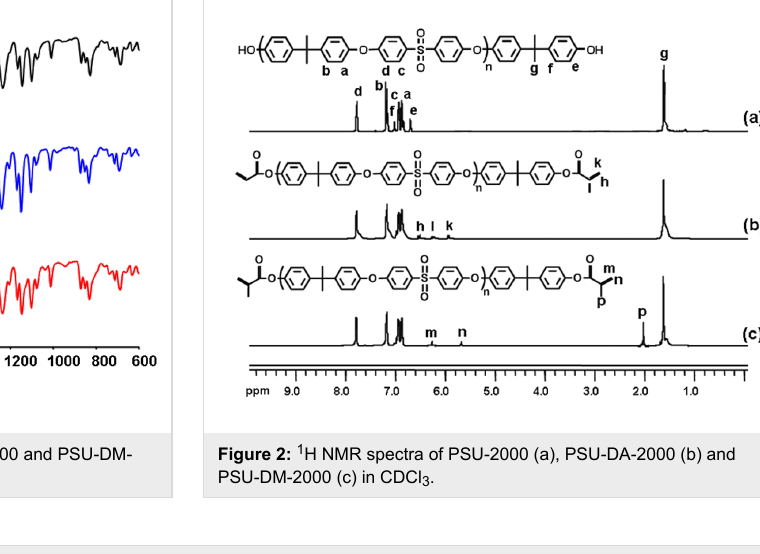
Table 1: Synthesis a and molecular weight characteristics of polysulfones.